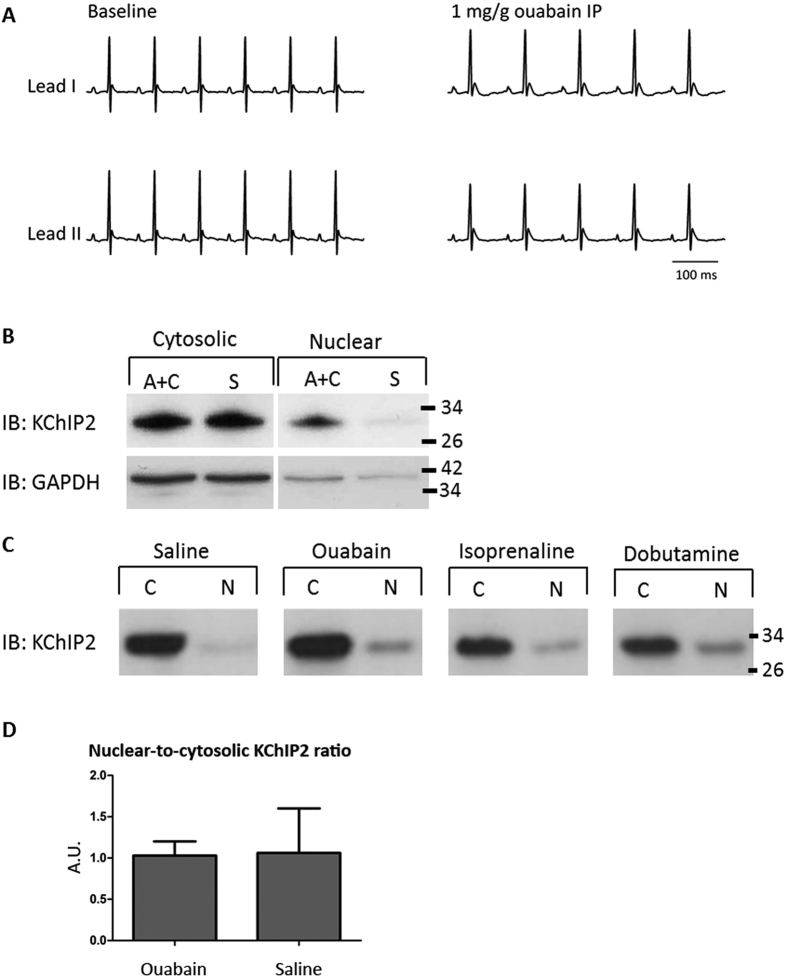
KChIP2 expression and subcellular localization in mouse hearts.(A) Representative two lead surface ECG from anesthetized mice at baseline and after treatment with 1 mg/g ouabain IP. (B) Exemplary immunoblots showing an increase of KChIP2 in the nuclear fraction when the mouse was treated with adrenaline and caffeine (A + C). Saline (S) treated mice served as controls. (C) Representative immunoblots showing the cytosolic (C) and nuclear (N) content of KChIP2 after administration of ouabain, isoprenaline and dobutamine, all increasing heart rate and inotropy, and saline as control. (D) Quantification of the nuclear-to-cytosolic ratio of KChIP2 in hearts from 5 ouabain-treated and 4 saline-treated mice and compared with Student’s t test.